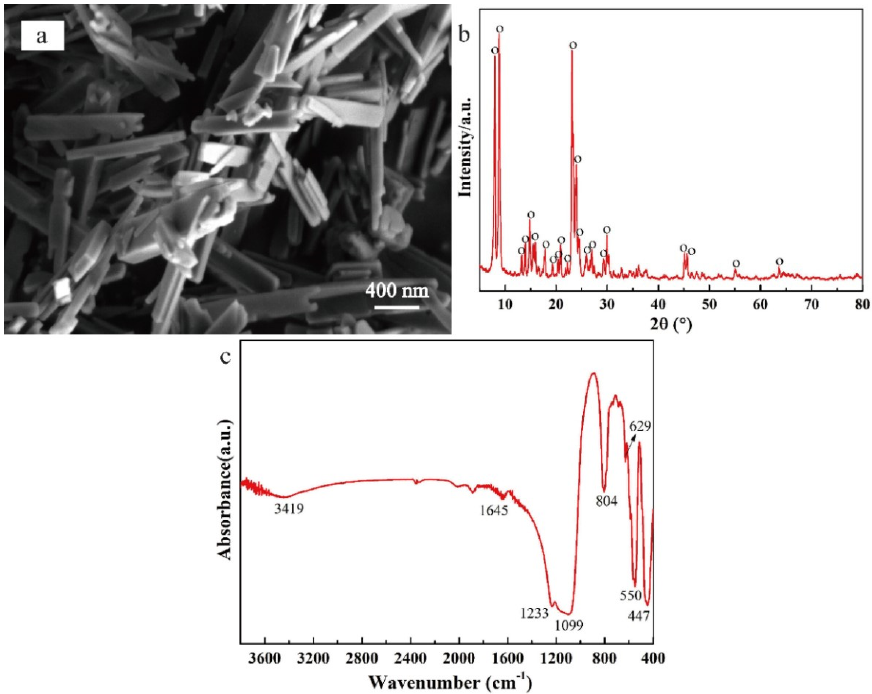
Figure 1. SEM images ( a ), XRD patterns ( b ) and FTIR spectrums ( c ) of silicalite-1 zeolites powders.